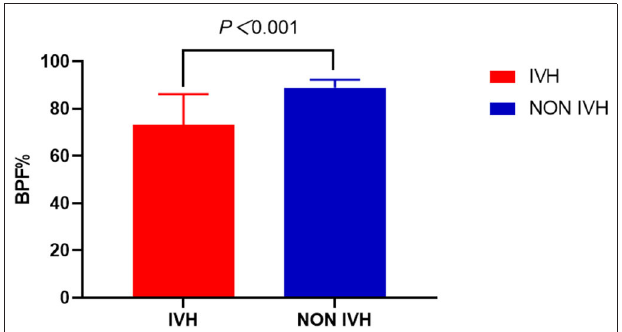
FIGURE 5 | Comparison of brain parenchymal fraction between IVH and NON IVH groups. The IVH group is displayed in red and the NON IVH group in blue. * p < 0.001 is defined as the significance level.